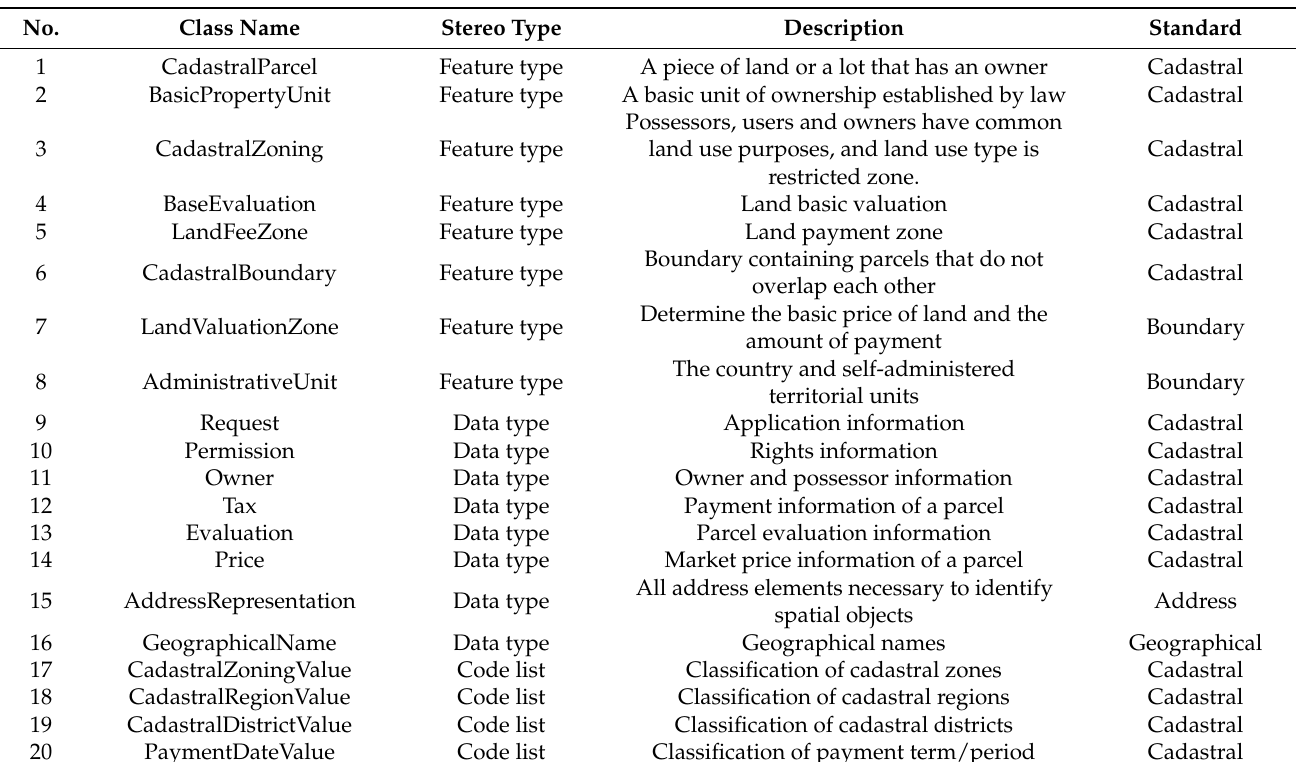
Table 1. Short description of UML class, datatype and code list of the cadastral parcel